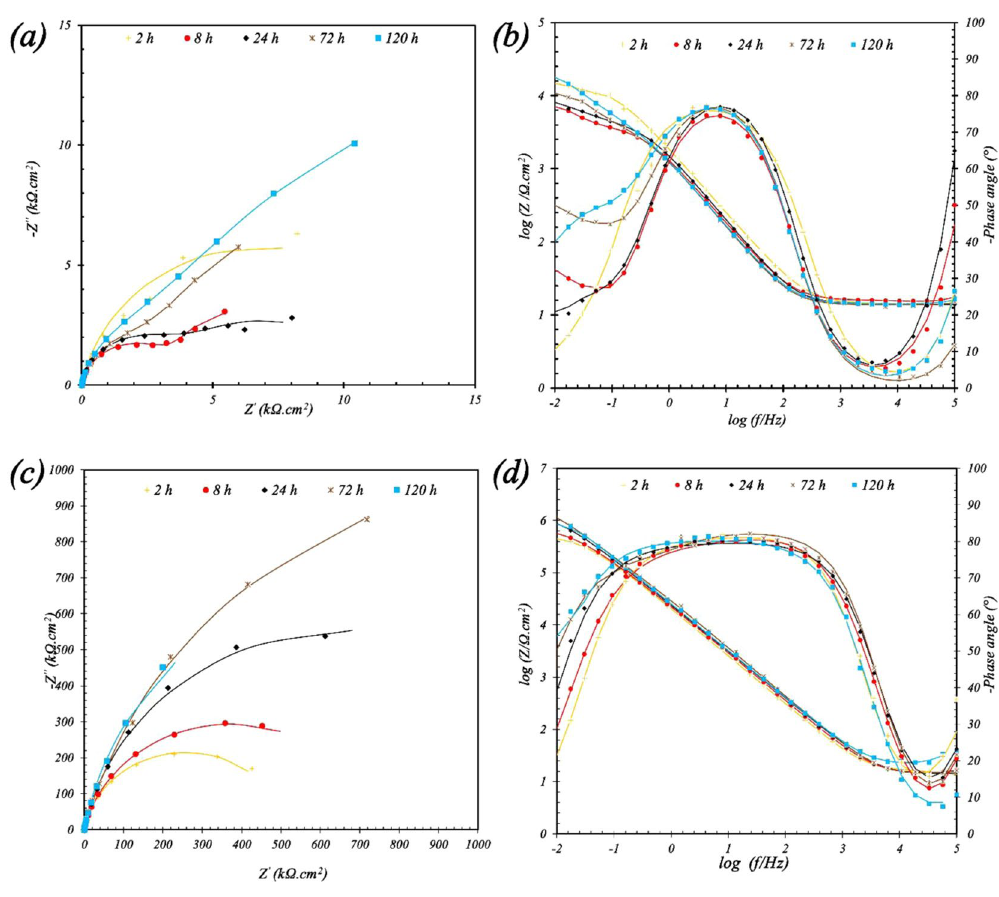
Figure 5. Nyquist and Bode plots for the 2024-T3 aluminum alloy at different immersion time soaked in various solutions: ( a,b ) 3.5 wt.% NaCl electrolyte, and ( c,d ) extract saline solution of the Ce-DEDTC complex.